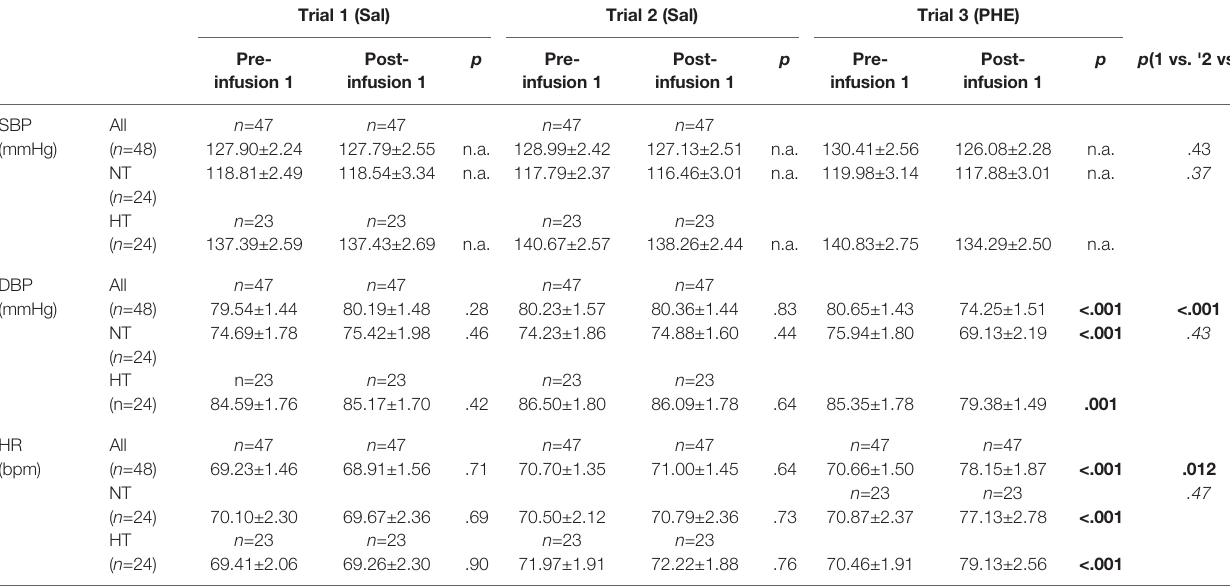
TABLE 2 | Cardiovascular reactivity to infusion 1: SBP, DBP, and HR levels pre and post infusion